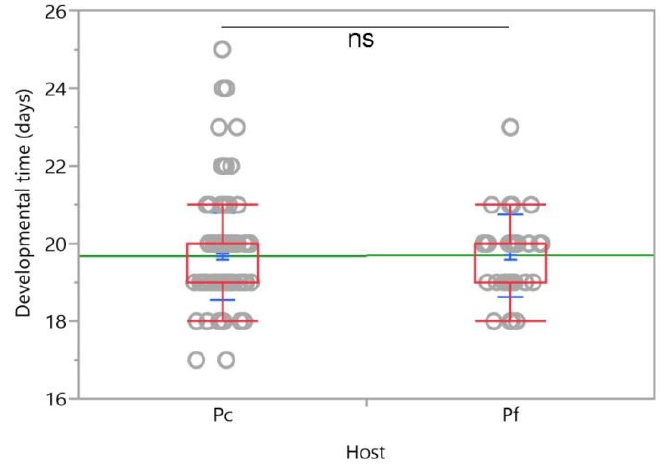
Figure 7. Developmental time of Anagyrus vladimiri from Pseudococcus comstocki (Pc) and Planococcus